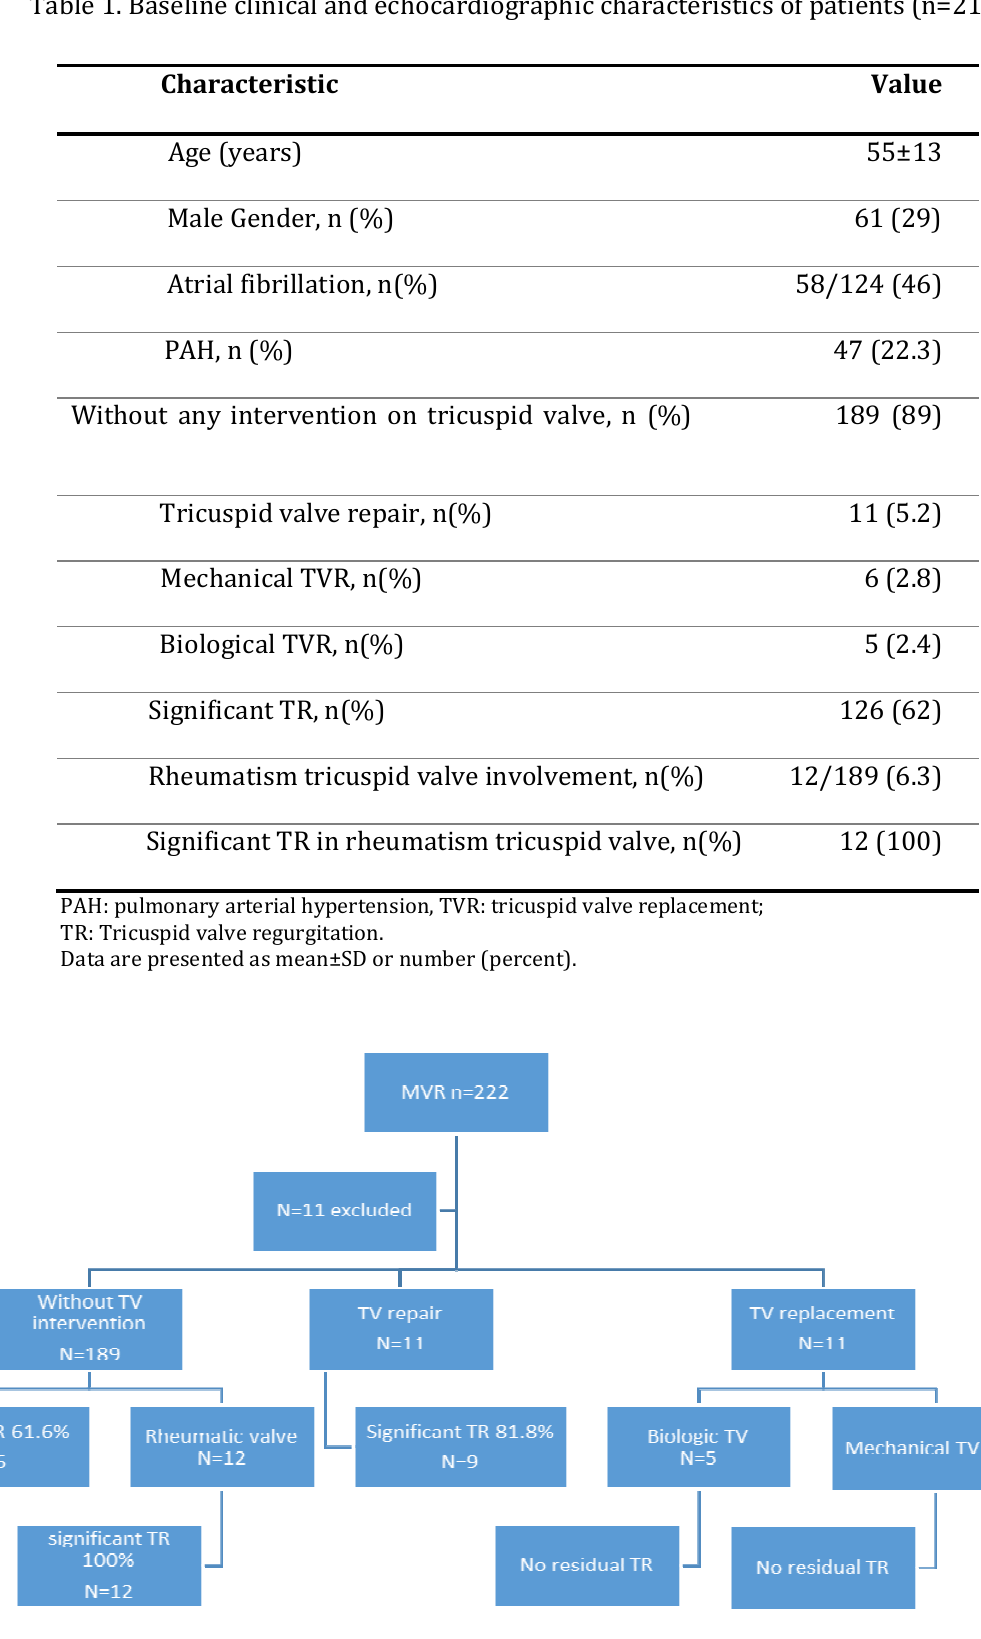
Table 1. Baseline clinical and echocardiographic characteristics of patients (n=211)